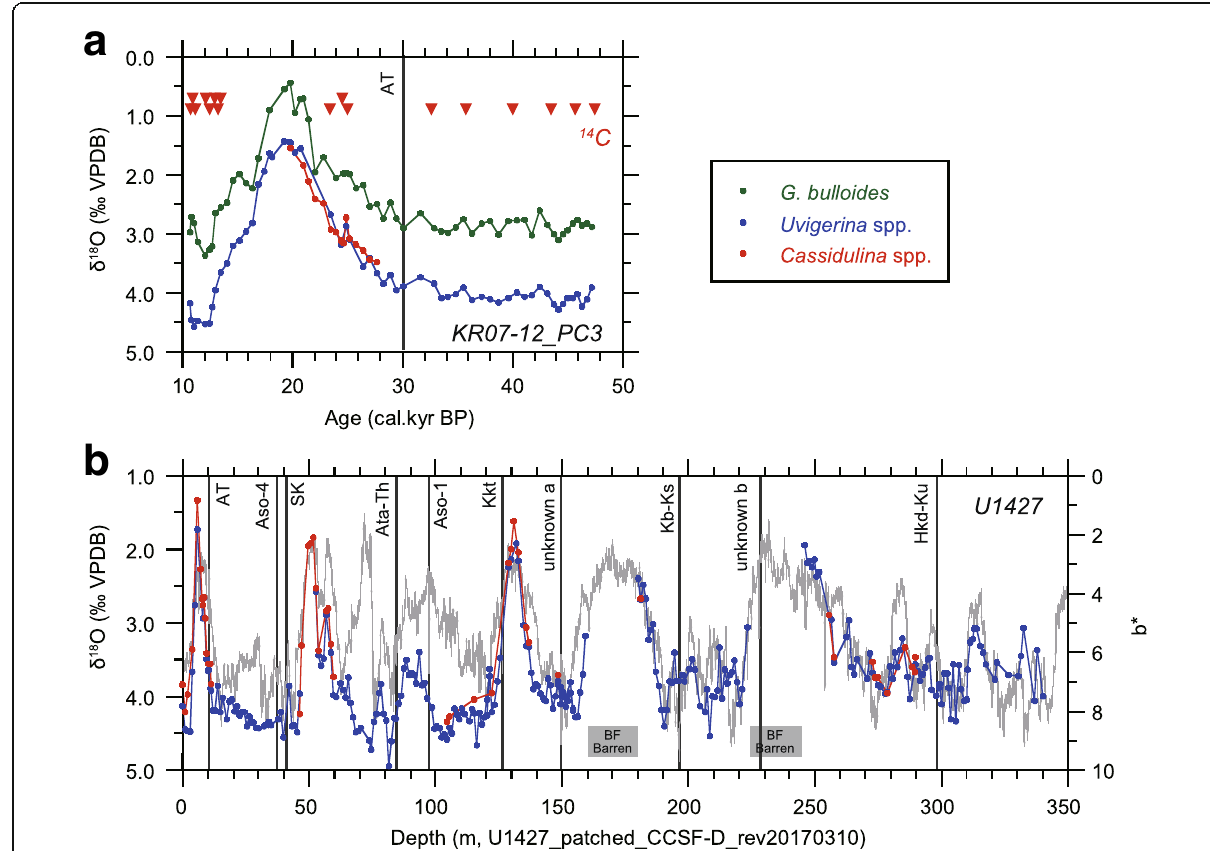
Fig. 5 δ 18 O records of a KR07-12 PC3 and b Site U1427. Red triangles in a indicate the positions of planktonic foraminiferal radiocarbon dates. The gray line in b shows the sediment color profile b* at Site U1427. The vertical lines in a and b denote tephra